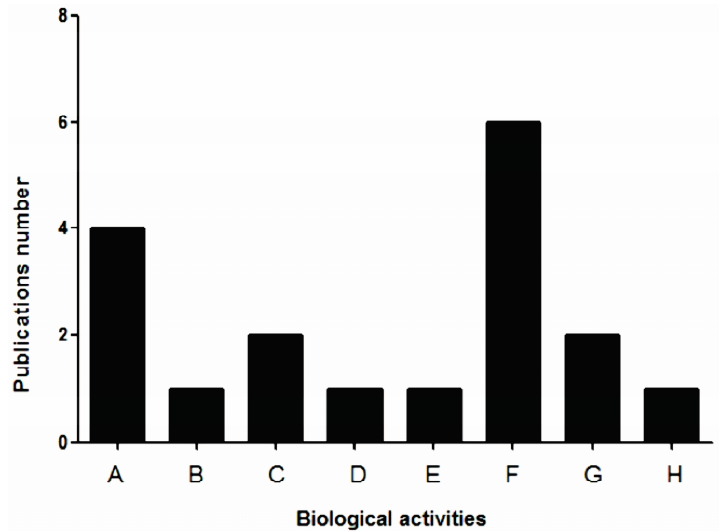
Figure 2. Biological activities found in lectins derived from marine sponges: (A) mitogenic activity; (B) binding to cells; (C) chemotaxis; (D) cytokine production; (E) pro-inflammatory; (F) toxicity; (G) recognition of Leishmania ; (H) modulation of ion